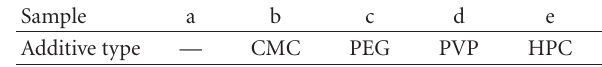
Table 1: Di ff erent samples of TiO 2 /ZnO.